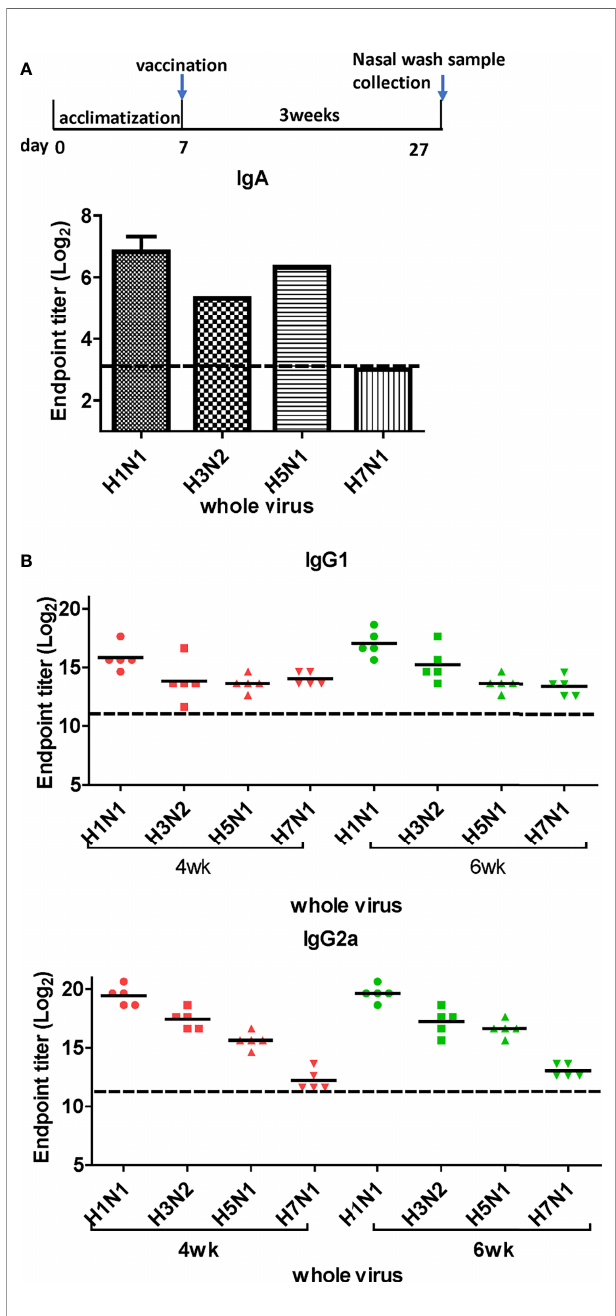
FIGURE 4 | Titration of cross-reactive antibodies by DM-C vaccination. (A) Response of IgA antibodies to whole in fl uenza A viruses in the respiratory system. Samples were diluted two-fold serially to measure the titer of IgA antibodies induced by LAIV vaccination in nasal turbinate samples harvested 3 weeks after vaccination. The graph shows the endpoint (E.P) of the pooled sample ( N=2 ). (B) Response of cross-protective systemic antibodies to whole in fl uenza A viruses. In fl uenza virus-speci fi c IgG1 and IgG2a were detected by ELISA. Two-fold serial diluted mice sera collected at 4 or 6 weeks post- vaccination were bound to whole viruses. The graph shows the endpoint (E.P) of each cohort (N=5). E.P means the reciprocal serum dilution of the vaccinated group that yielded OD 450 greater than the mean + 2SD of the PBS-treated